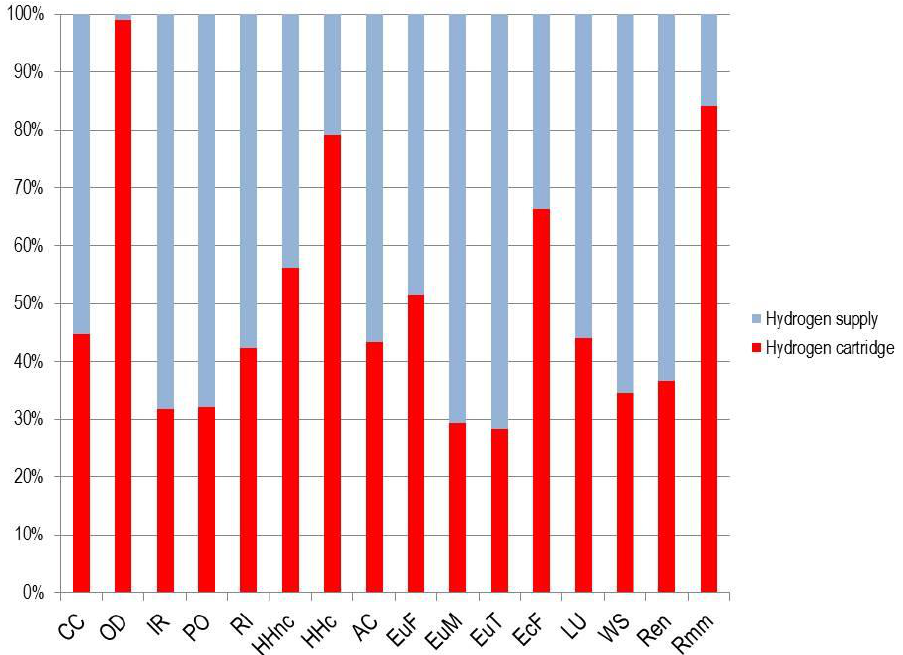
Figure 4. Relative contribution to the EF of the hydrogen cartridge and supply.